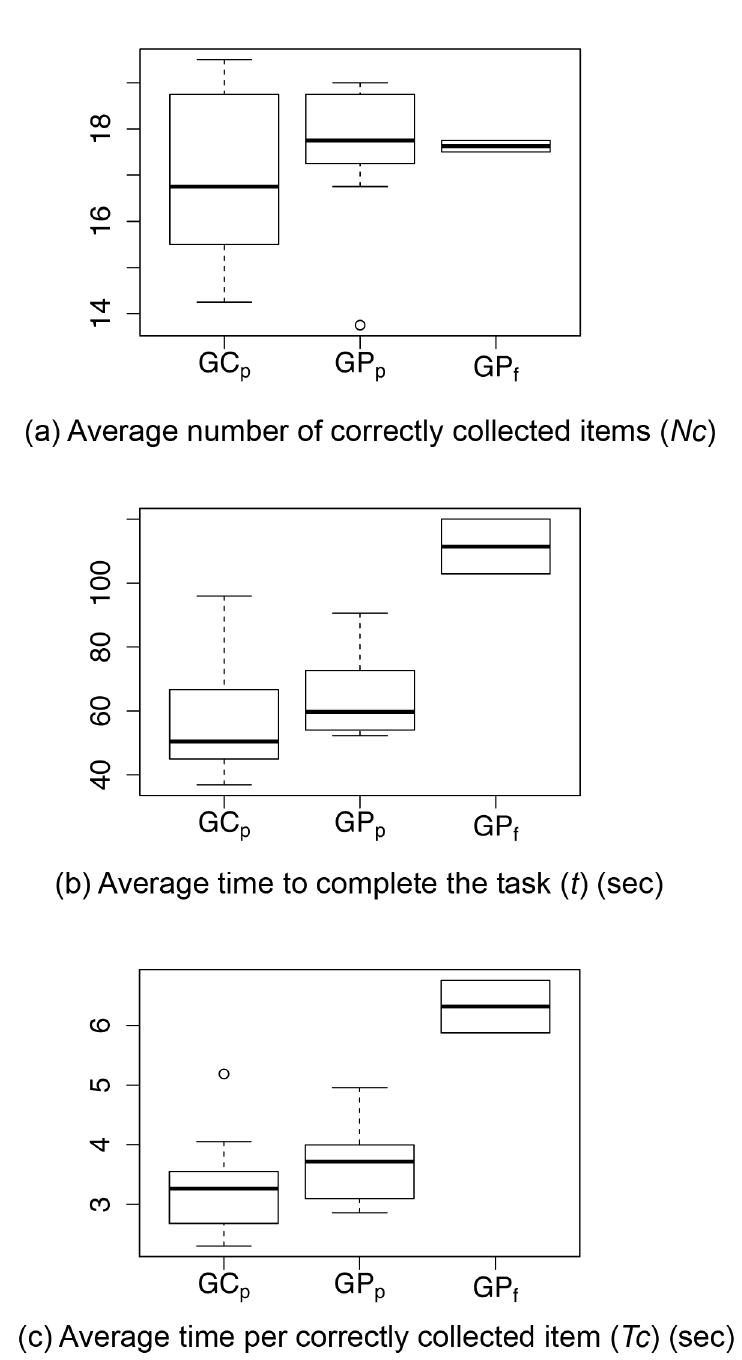
Figure 2. Value range for (a) the average number of correctly collected items over all runs, (b) the average time needed to complete the supermarket search task over all runs, and (c) the average time (over all runs) per correctly collected item. The participant subgroups are marked by GCp/GPp (glaucoma controls/patients who passed), GPf (glaucoma patients who failed).